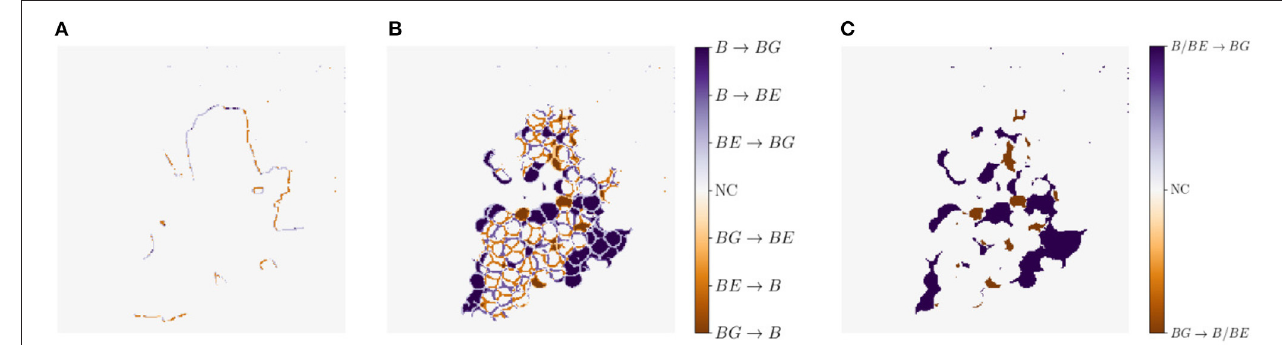
FIGURE 7 | Example representation of generation maps in (A) the occluded domain, and (B,C) the non-occluded domain for the berry mask (B) and a binary mask (C) where classes berry B and berry-edge BE are combined to one class. Background is indicated by BG and if there is no class change it is indicated by NC for no change.